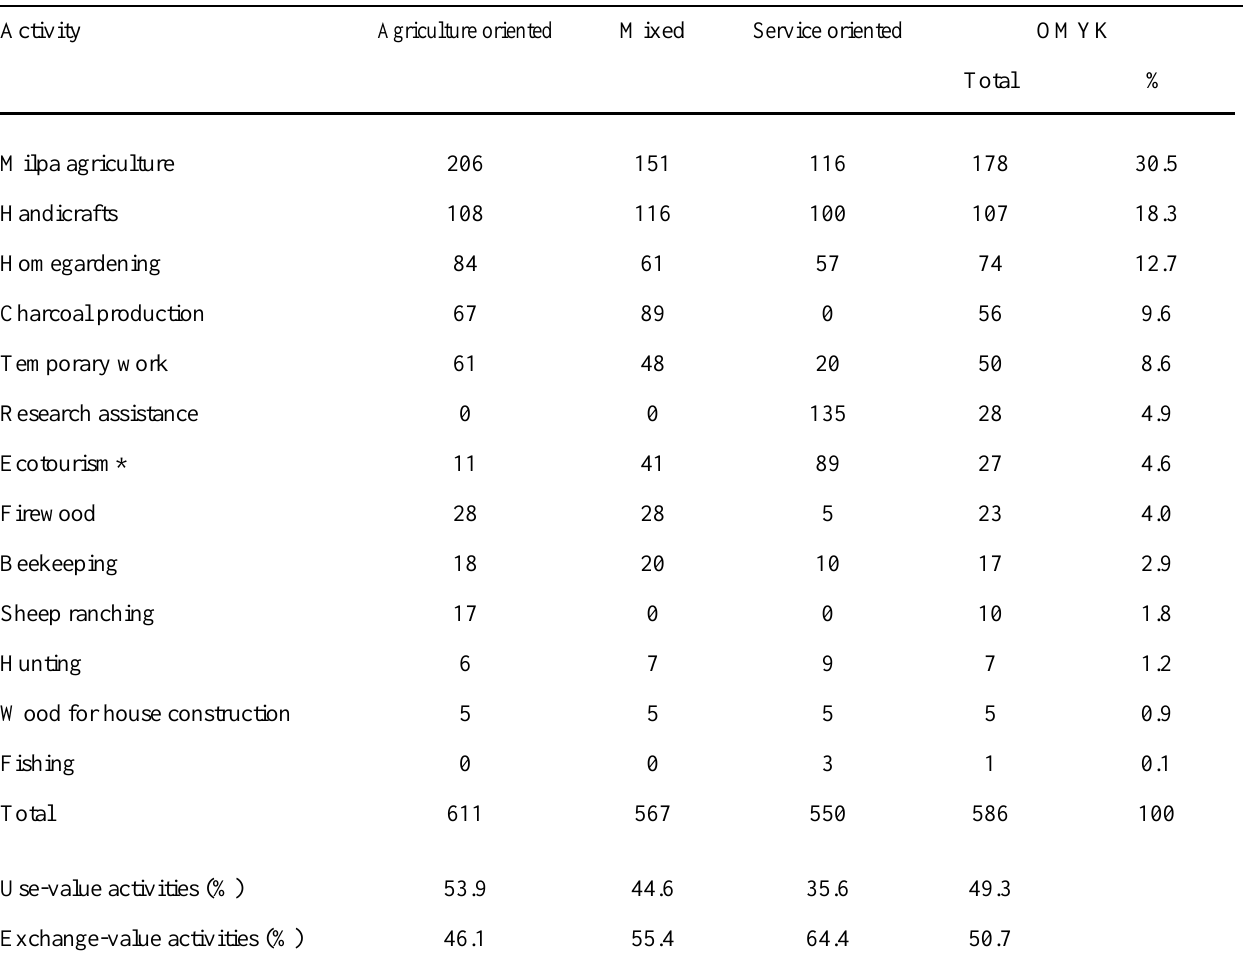
Table 2. Annual estimated work days allotted to each activity. Numbers are per household, characterized by their productive strategy and based on an 8-hour work